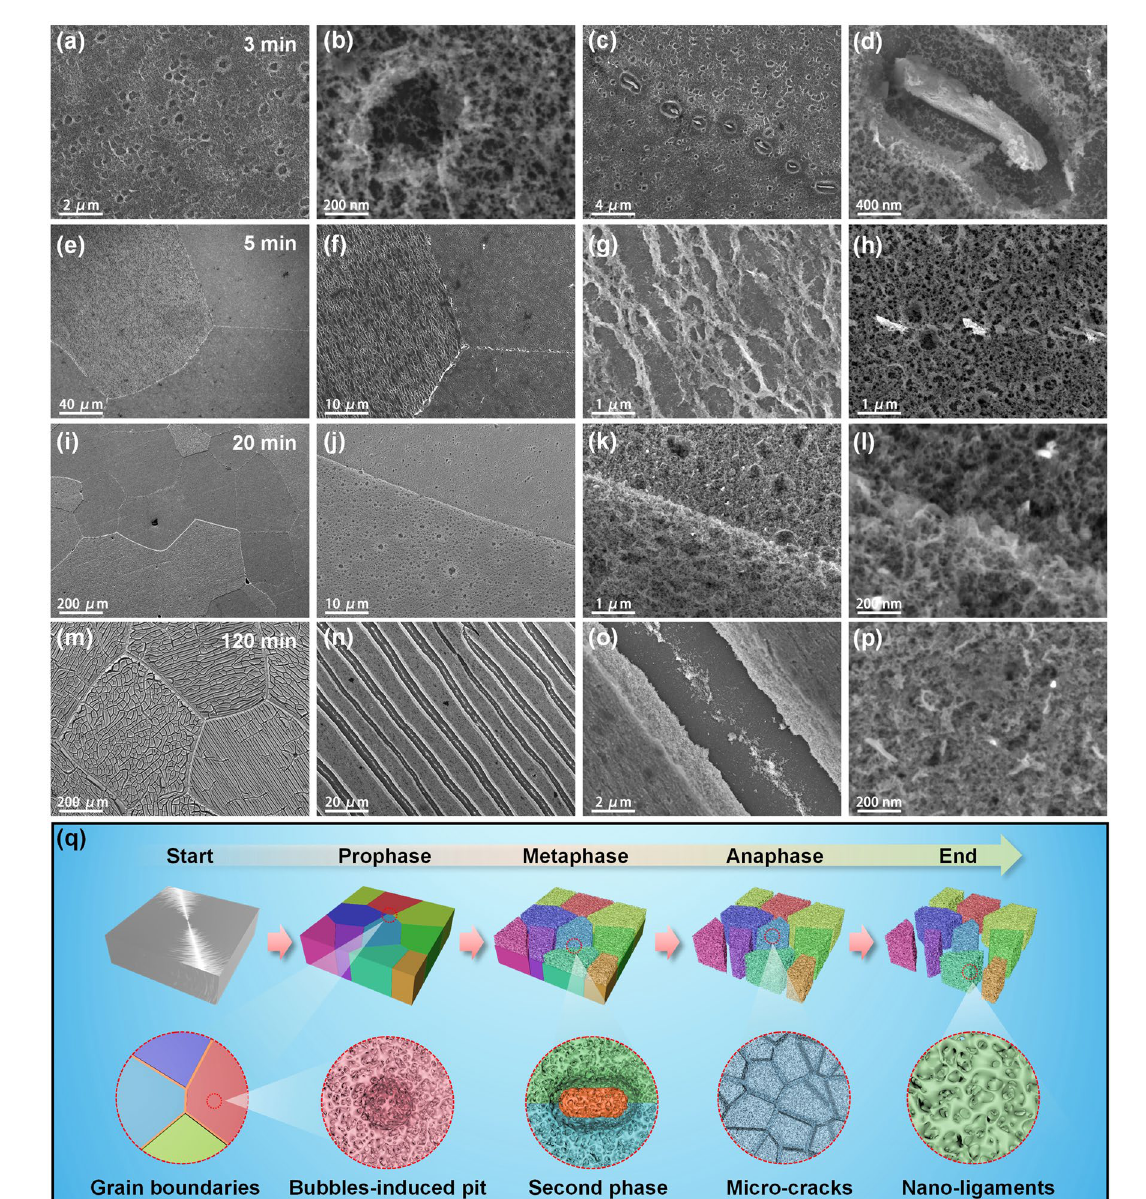
Fig. 2 Plan-view SEM images of Al 98 Cu 2 dealloyed for ( a–d ) 3, ( e–h ) 5, ( i–l ) 20, and ( m–p ) 120 min in the 0.5 M NaOH solution. q Schematic illustrations showing the microstructure evolution of